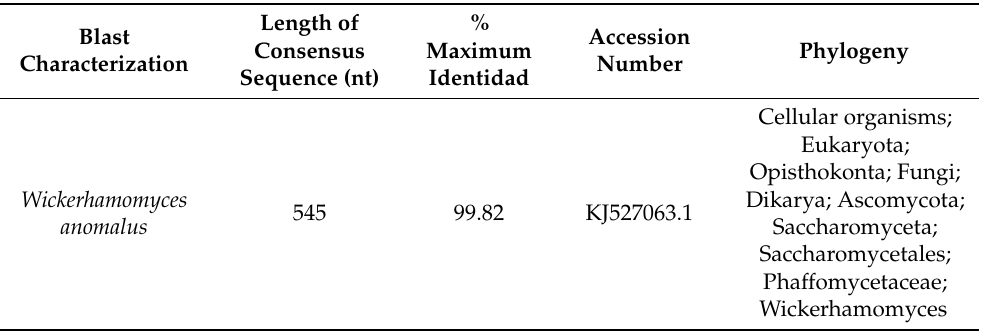
Table 1. BLAST characterization of the rDNA sequence of yeast isolated from the MFC anode plate with pineapple debris substrate.